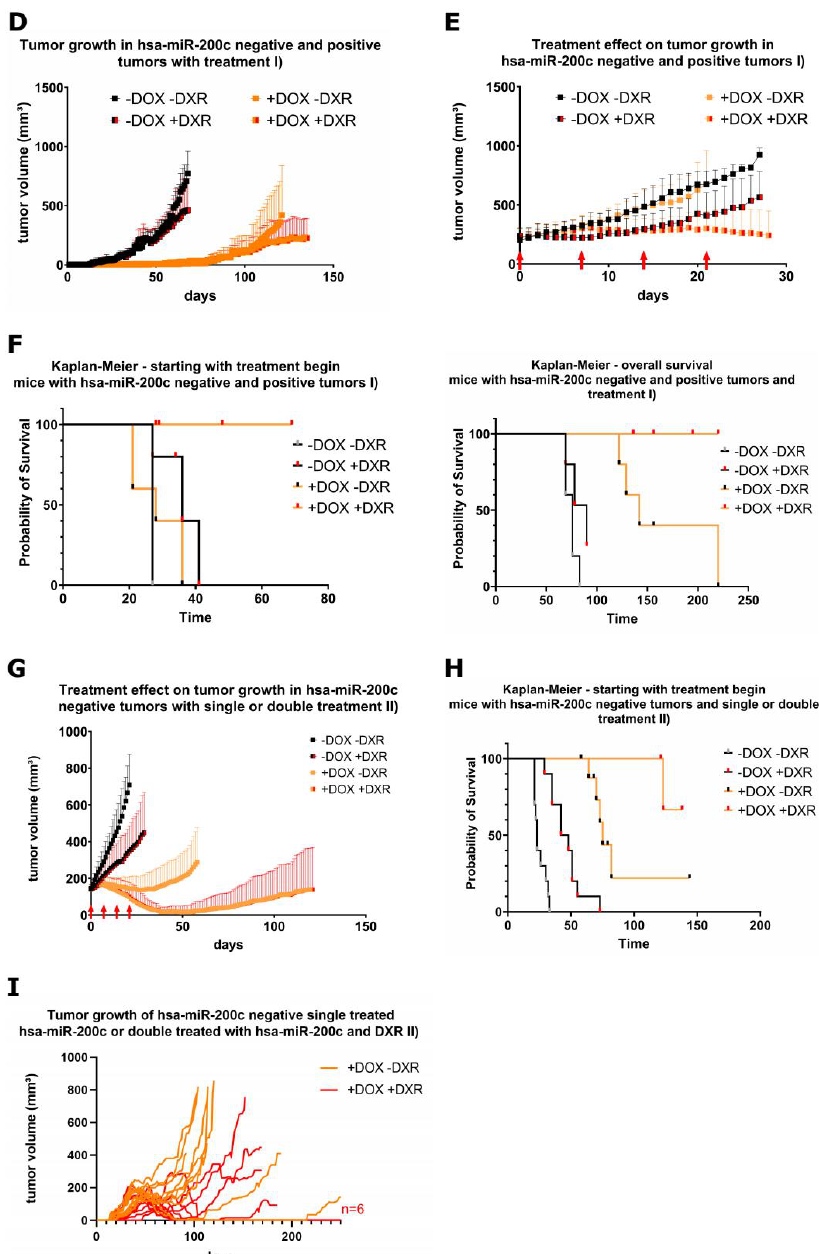
Figure 6. Long-term effect of hsa-miR-200c expression in vivo on tumor growth and resistance. ( A ) Two xenograft mouse models to investigate tumor growth: (I) Scheme for the analysis of hsa-miR-200c positive and negative tumors and additional chemotherapeutic treatment. (II) Xenograft mouse model of MDA-MB 231 Tripz 200c tumors to examine single doxorubicin (DXR) or hsa-miR-200c treatment and their combination. ( B ) Tumor growth of MDA-MB 231 Tripz Ctrl (control sequence expressing tumors) vs. MDA-MB 231 Tripz 200c ( n = 5 per group) under regular (black) or DOX diet (orange). ( C ) Corresponding molecular analysis of the control (top) and hsa-miR-200c (bottom) inducible xenograft mouse model. Quantitative RT-PCR analysis of the expression levels of GSTM3 and hsa-miR-200c. DOX induction is indicated in orange. ( D ) Evaluation of the development of hsa-miR-200c positive ( n = 5, orange curves) and negative tumors ( n = 5, black curves) and their treatment with DXR (red-filled squares) based on tumor growth. ( E ) Tumor growth analysis normalized to treatment begin (set as day 0) in hsa-miR-200c positive and negative tumors with or without DXR treatment. Red arrows indicate treatment days (days 0, 7, 14 and 21). ( F ) Kaplan–Meier analysis